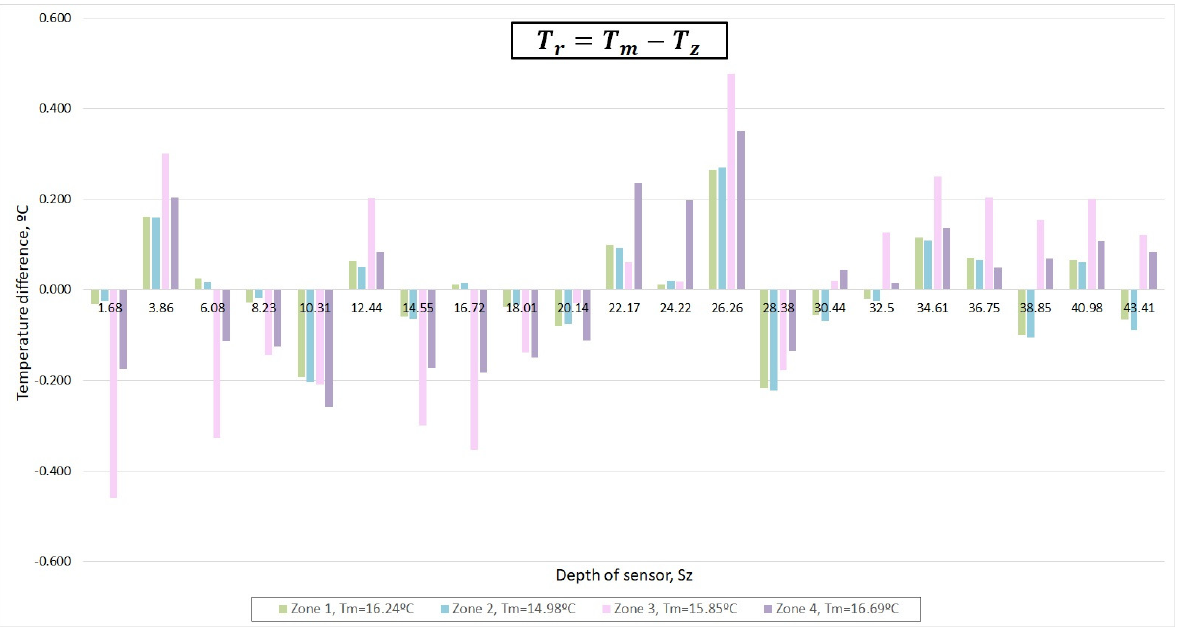
deviation trend from the mean. Figure 20. Temperature measured by S3.86 and S10.31 sensors, characterized by maintaining the